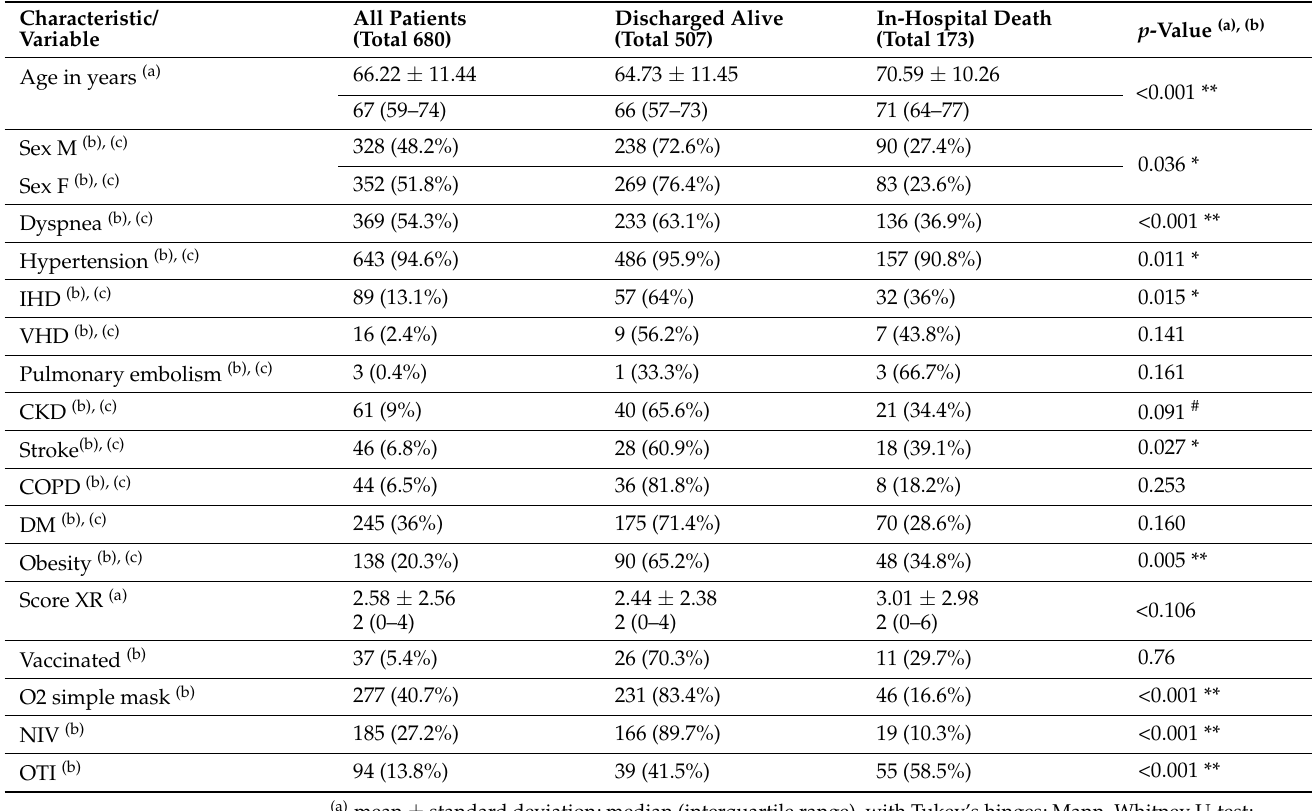
Table 4. Relationship between patients’ characteristics and in-hospital mortality.